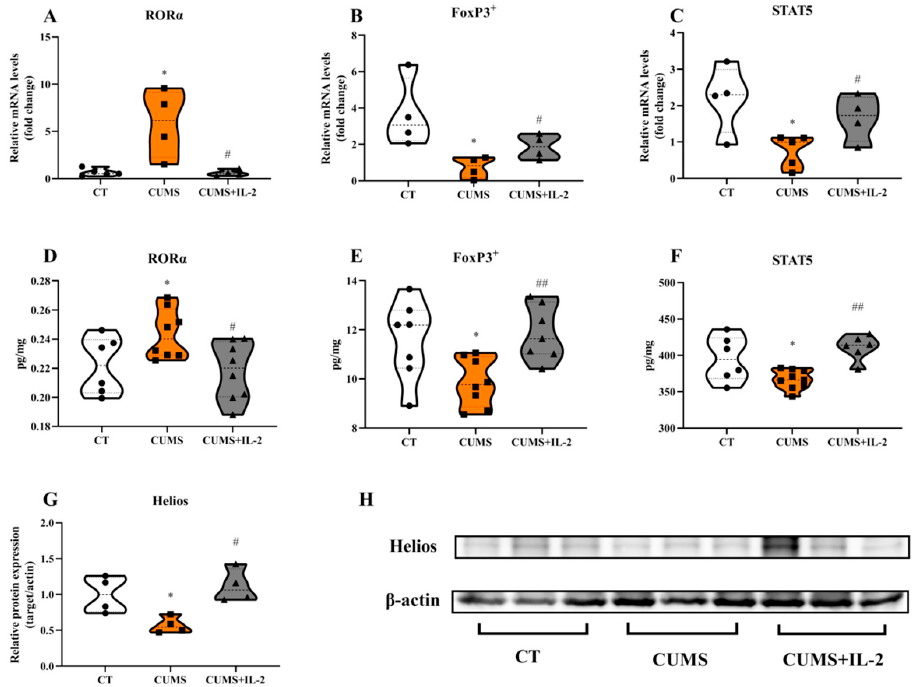
Figure 5. IL-2 restored the mRNA and protein expression of Th17 and Treg cell transcription factors in the hippocampus of CUMS mice. Th17 transcription factor RoR α ( A , D ), Treg transcription factor FoxP3 + ( B , E ), STAT5 ( C , F ) and Helios ( G , H ) in the hippocampus (n = 4–8). CT, control group; CUMS, CUMS group; CUMS+IL-2, CUMS exposure with IL-2 treatment. * p < 0.05 vs. CT; # p < 0.05, ## p < 0.01 vs. CUMS.